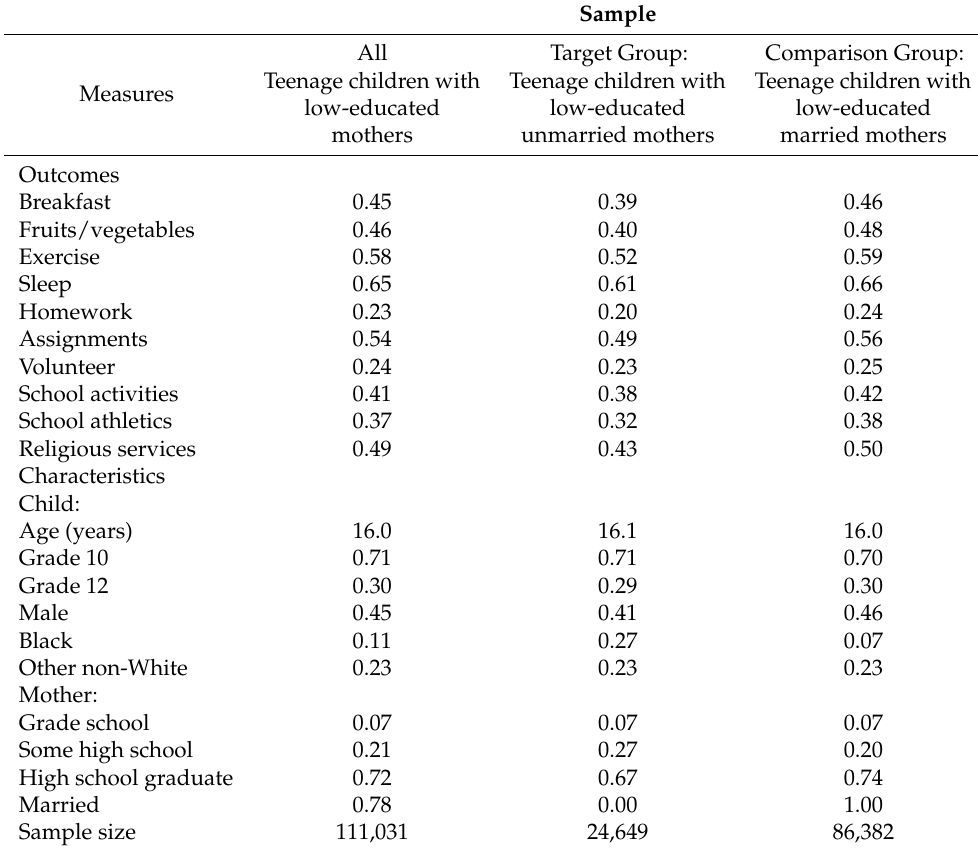
Table 1. Outcomes and Sample